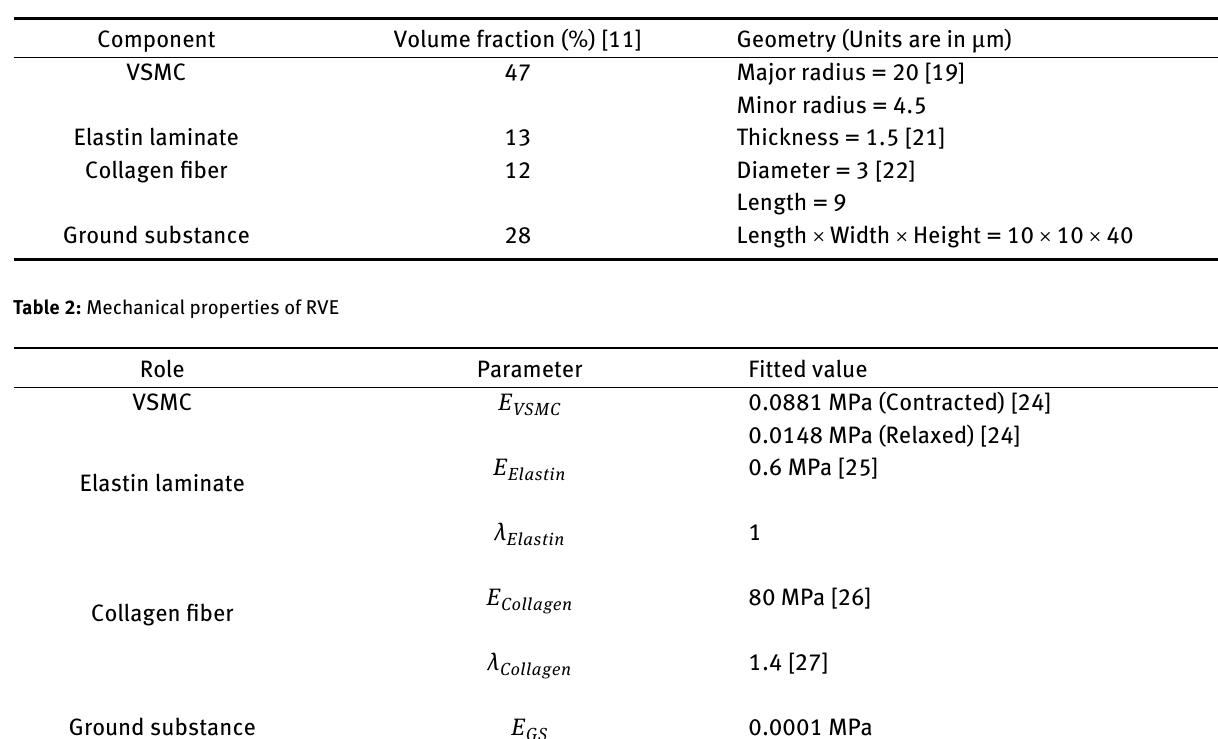
Table 1: The volume fraction and geometry of RVE constituents